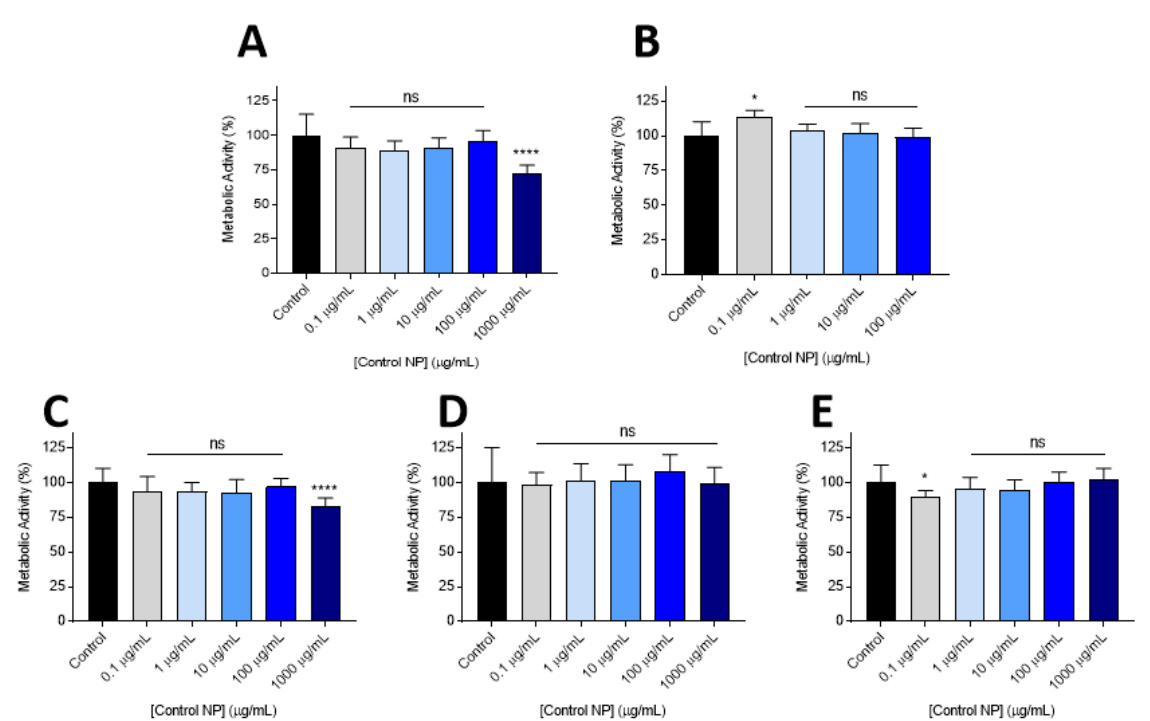
Figure 3. In vitro cell viability following dosing with (0.1–1000 µ g/mL) P2 NP formulation for 72 h in human astrocytes ( A ), 9L rat glioma ( B ), GIN-8 ( C ), GIN-28 ( D ) and GIN-31 ( E ) cell lines. Metabolic activity was assessed using the PrestoBlue™ assay. Four independent repeats ( n = 4) were carried out. Error bars show the mean ± SD. [ns: p > 0.05; *: p < 0.05; ****: p < 0.0001, unpaired t -test with Welch's correction, comparing each data set to the control (negative control; medium) data set].